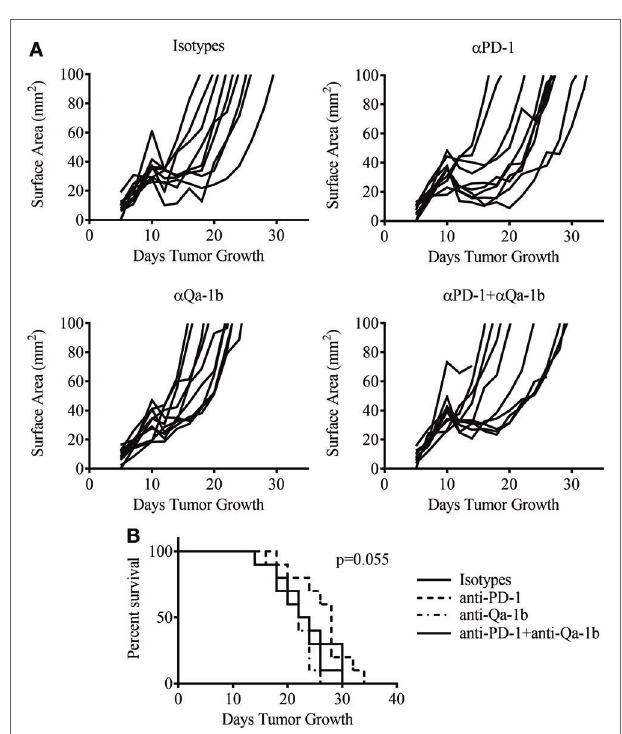
FigUre 8 | Dual checkpoint blockade does not enhance efficacy of MCMVgp100KGP vaccination. Mice were challenged with B16F10 i.d. and 5 days later received PMEL transfer i.v. and 10 5 PFU MCMVgp100KGP vaccination i.p. Mice were treated with isotype, anti-PD-1, and/or anti-Qa-1 b antibodies i.p. on days 10, 12, and 14. (a) Tumor growth curves from individual mice. (B) Survival curves from different treatment groups. Data are accumulated from two independent experiments with 10 mice/group total.